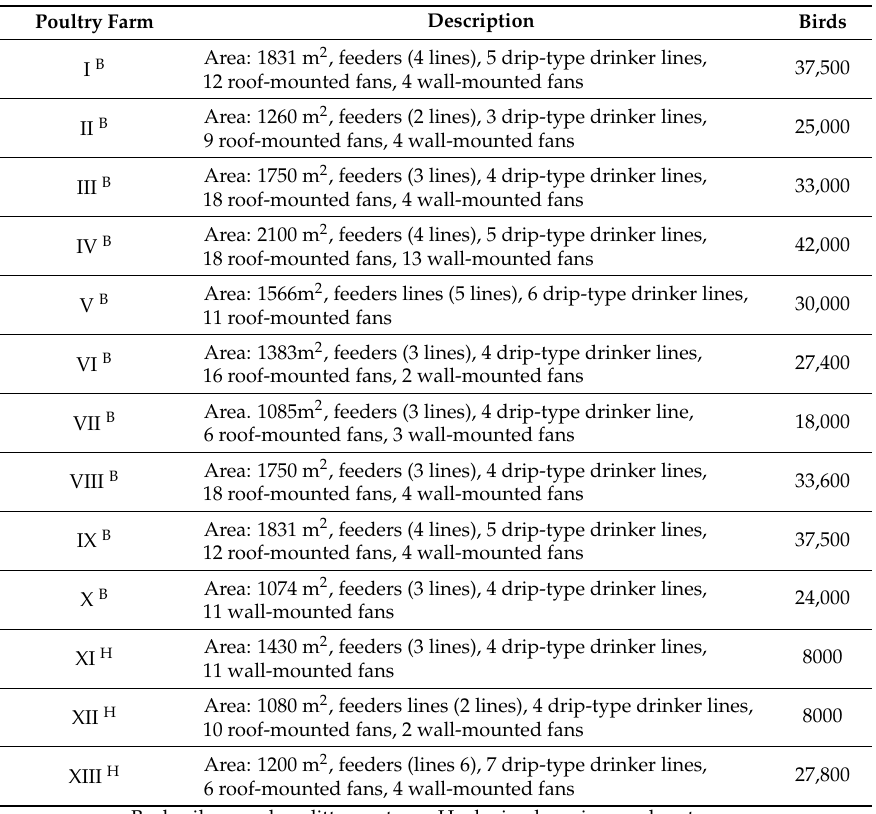
B—broilers on deep litter systems; H—laying hens in caged